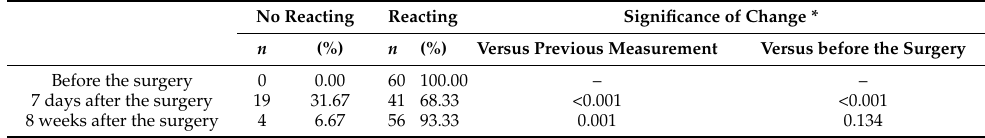
Table 6. Percentage of unresponsive teeth to EPT at each time